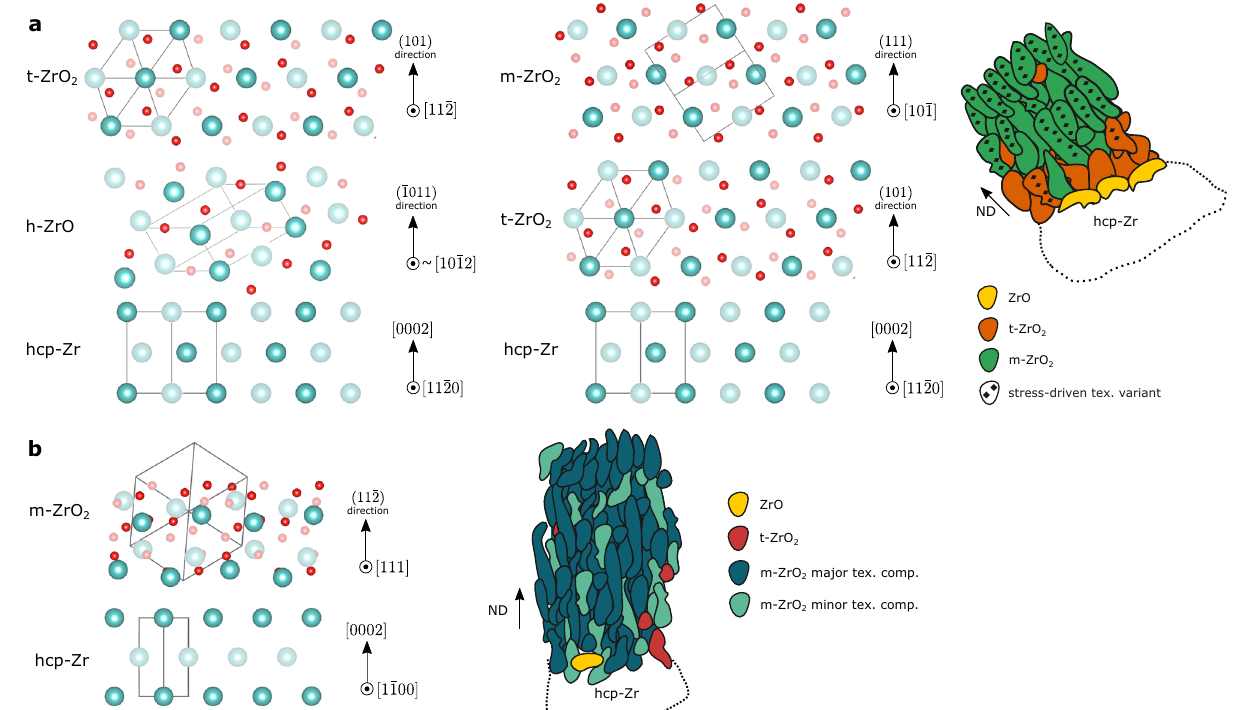
Fig. 8 | Atomic structure ofinterface. Schematic of the interfaces formed based on the identi fi ed orientation relationships. a Region 1: f 101 g <11 (cid:1) 2> t (cid:2) ZrO <10 (cid:1) 12> ZrO ∣∣ f 0002 g <11 (cid:1) 20> Zr (left) and f 111 g <10 (cid:1) 1> m (cid:2) ZrO <11 (cid:1) 20> Zr (right). b Region 2: f 11 (cid:1) 2 g <111> m (cid:2) ZrO planes shown in the out-of-page direction, where shade indicates the atoms ’